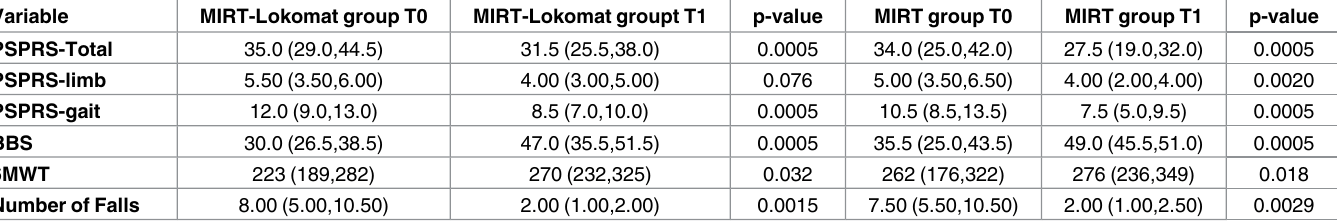
Table 2. Baseline and end of treatment values of outcome variables for both groups of patients. Reportedp-valuesare computedby the Wilcoxon signed rank test. Data are reportedas median(lower quartile, upper quartile).